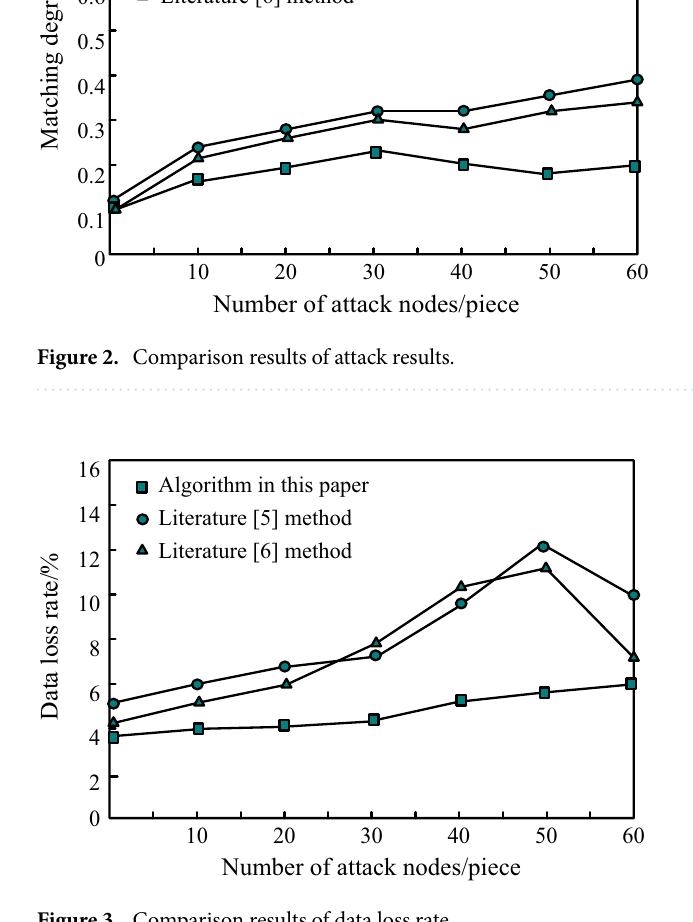
Figure 3. Comparison results of data loss